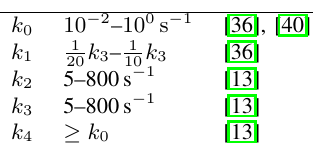
B IOLOGICALLY REASONABLE RANGES FOR THE RATE CONSTANTS k